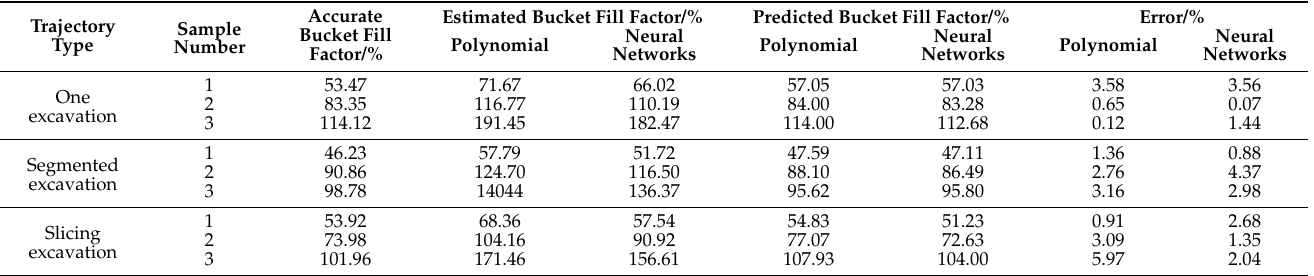
Table 6. Statistics of the results under the polynomial regression method on the validation